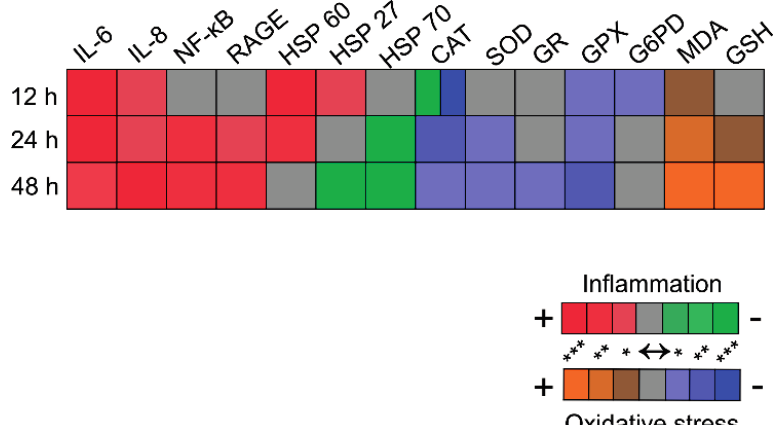
Figure 3. Antioxidative defence in HEK 293 cells and oxidative stress induced by AGEs exposure. ( a ) Representative zymogram indicating the activity of SOD enzymes and combined densitometry data of three zymograms indicating fold changes in Mn–SOD and Cu/Zn–SOD activities. The specific activities of total ( b ) SOD; ( c ) CAT; ( d ) GPX; ( e ) G6PD; ( f ) glutathione reductase (GR) antioxidative enzymes; ( g ) GSH and ( h ) advanced lipid oxidation end products (MDA, malondialdehyde). In ( b – h ), when statistically significant, the percent change values were given. * p < 0.05; ** p < 0.01; *** p < 0.001.